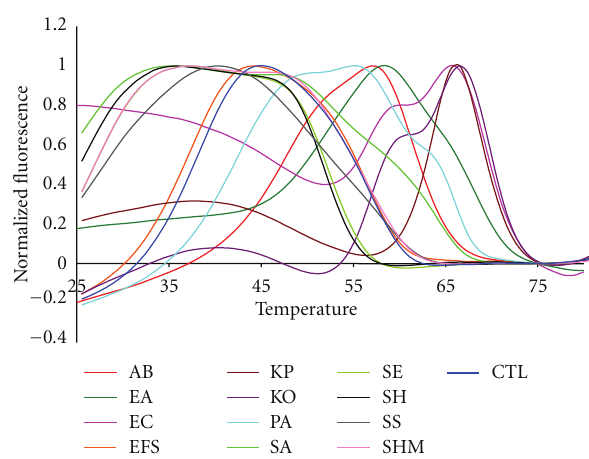
Figure 2: The normalized anneal curve showing all 16S targets in the Quasar channel with their highest peak normalized to 1.0.